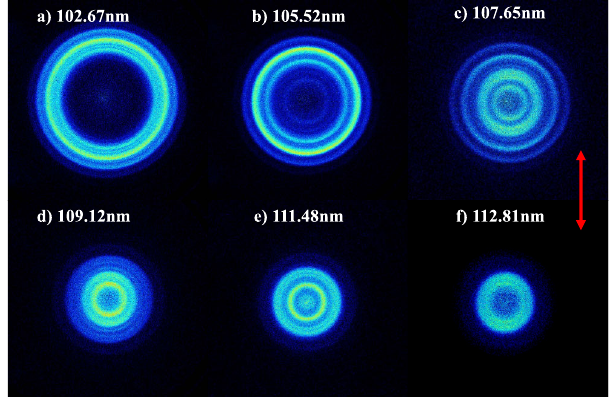
Fig. 2 Wavelength dependent time-sliced velocity map images from H 2 O photolysis. Time-sliced images of the O( 1 S) photoproducts from photodissociation of H 2 O at a 102.67, b 105.52, c 107.65, d 109.12, e 111.48, and f 112.81nm. The red double arrow indicates the polarization direction of the dissociation laser. The ring features correspond to the rovibrational states of the coincident H 2 (X, v )